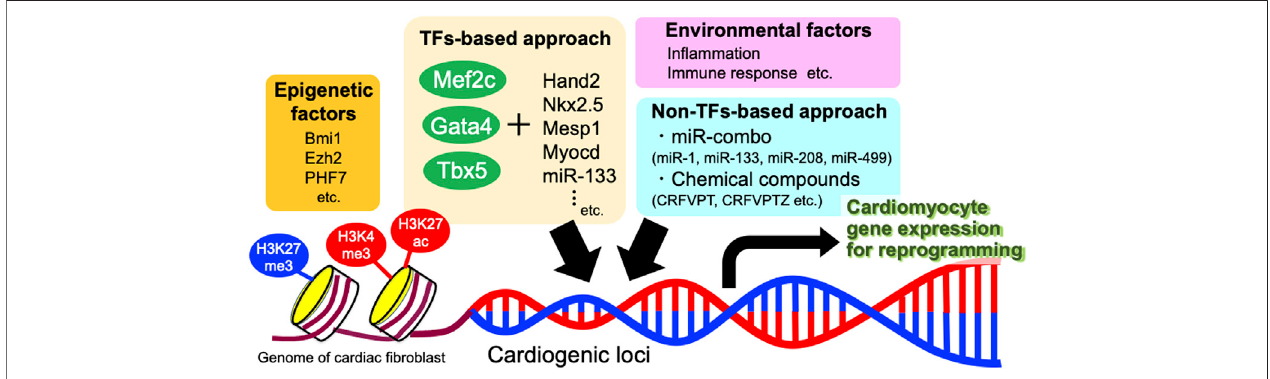
FIGURE 2| Molecular mechanisms involved in direct reprogramming ofcardiac fi broblastsinto cardiomyocytes. Major methods include TFs-based approach and non-TFs-based approach. Besides, various epigenetic factors and environmental factors also affect the ef fi ciency of direct reprogramming. TFs, transcription factors; miR,